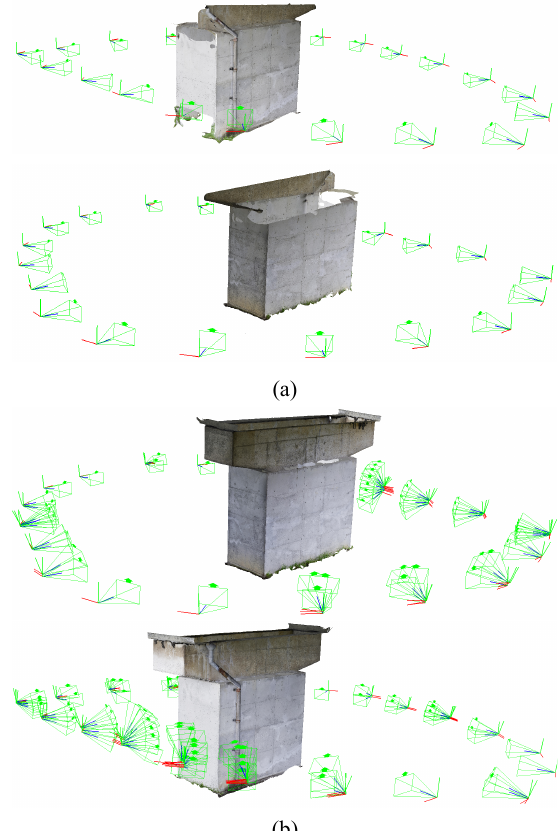
Figure 8. The reconstructed final dense models and the camera poses: (a) initial camera poses